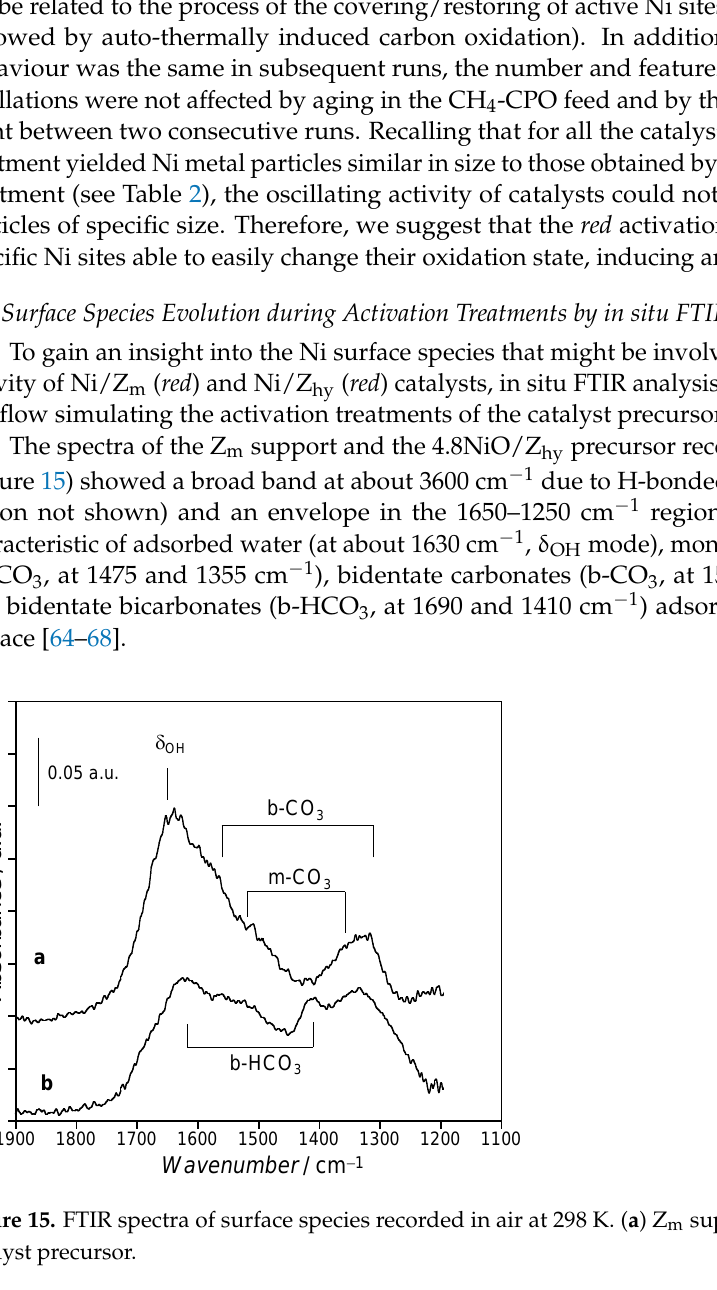
Figure 16. In situ FTIR spectra of surface species during activation treatments on 4.8NiO/Z hy cata- lyst precursor. Spectra recorded in O 2 /N 2 oxidative flow ( a ), and in H 2 /N 2 reductive flow ( b ) at in- creasing temperature.